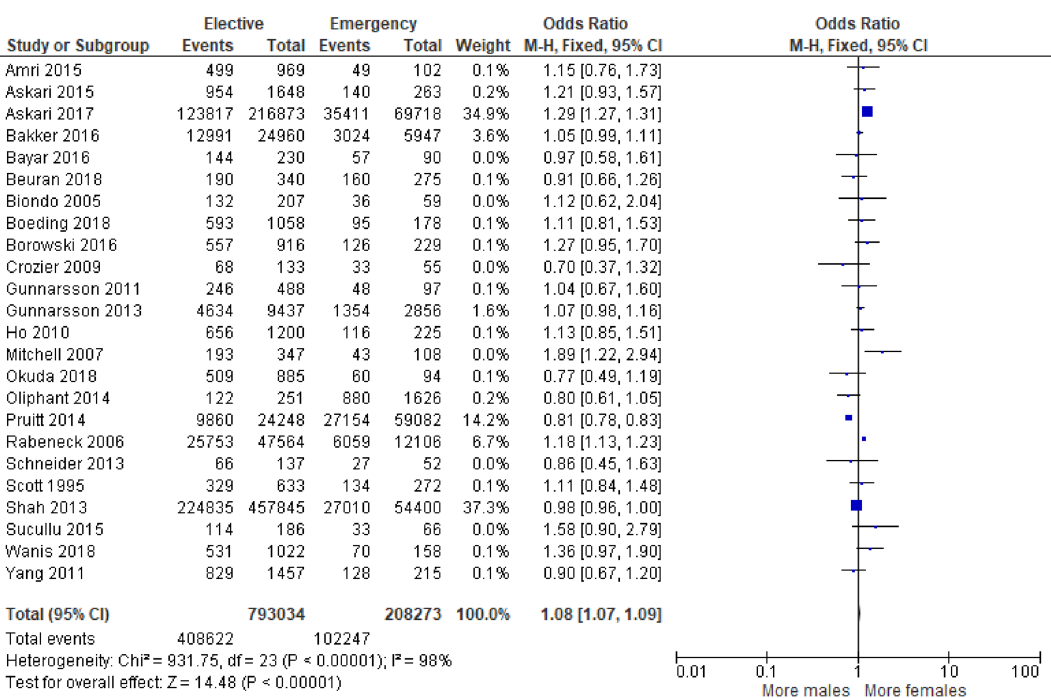
Figure 11. Association between tumour grade/differentiation and emergency presentation—Forest Plot.